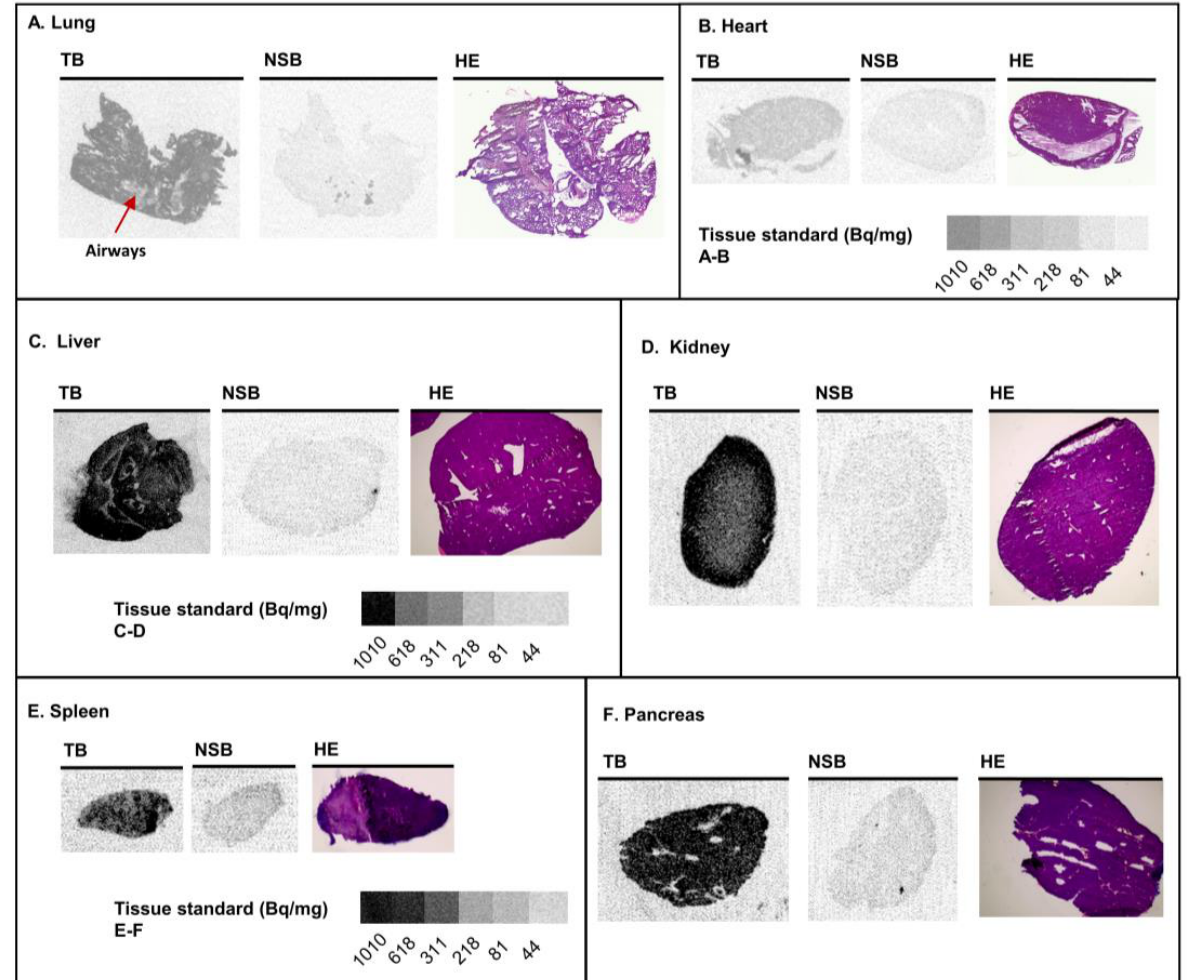
Figure 2. Representative images of tissue sections obtained from healthy female CD1 mice showing total radioligand binding (TB), non-specific binding (NSB; determined in presence of 5 µM FR), and hematoxylin-eosin staining (HE) of ( A ) lung, ( B ) heart, ( C ) liver, ( D ) kidney, ( E ) spleen, and ( F ) pancreas. Organ slices were incubated with 10 nM of [ 3 H]PSB-15900-FR for 1 h at room temperature. Tissue equivalent standards are displayed below the respective panels.